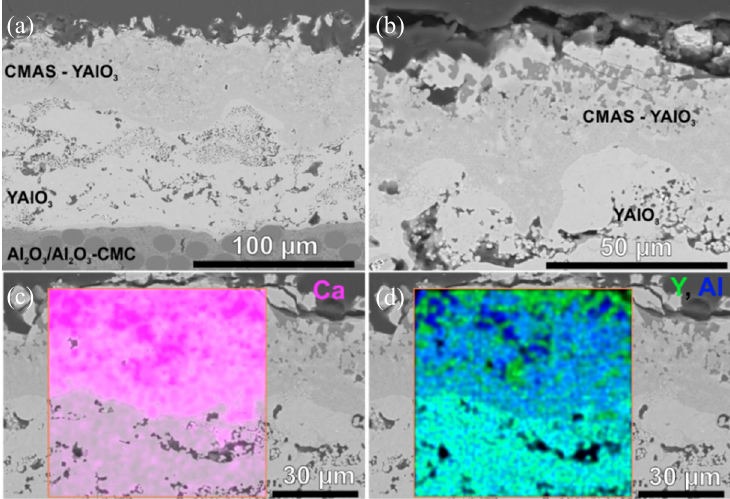
Figure 13. SEM images of the VLPPS YAlO 3 coatings after 274 cycles in the CMAS test rig ( a , b ). EDS mappings for Ca ( c ) and Y and Al ( d ).